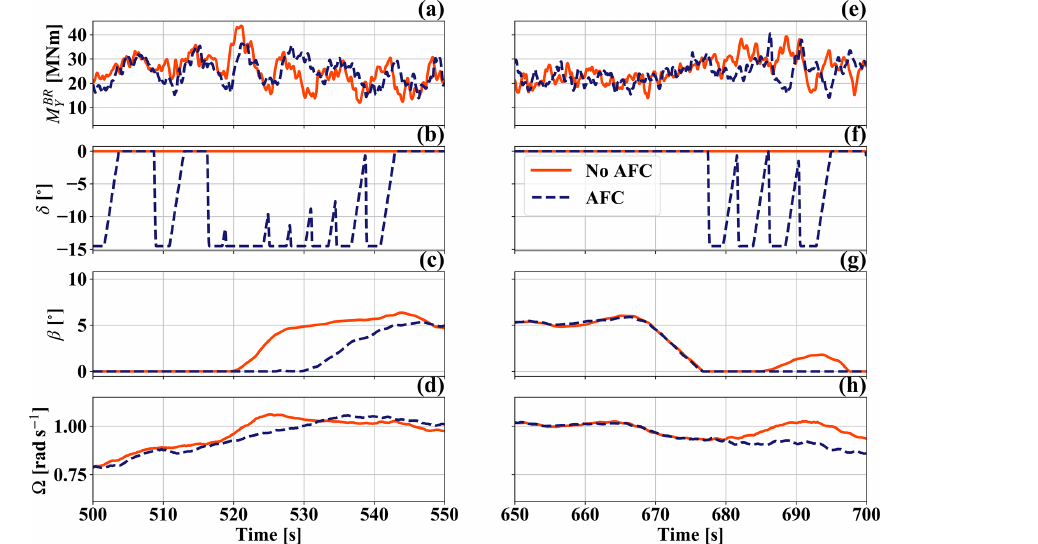
Figure 12. Selection of time series for two different simulations with V hub = 11ms − 1 . Panels (a–d) correspond to one simulation while panels (e–h) correspond to the second